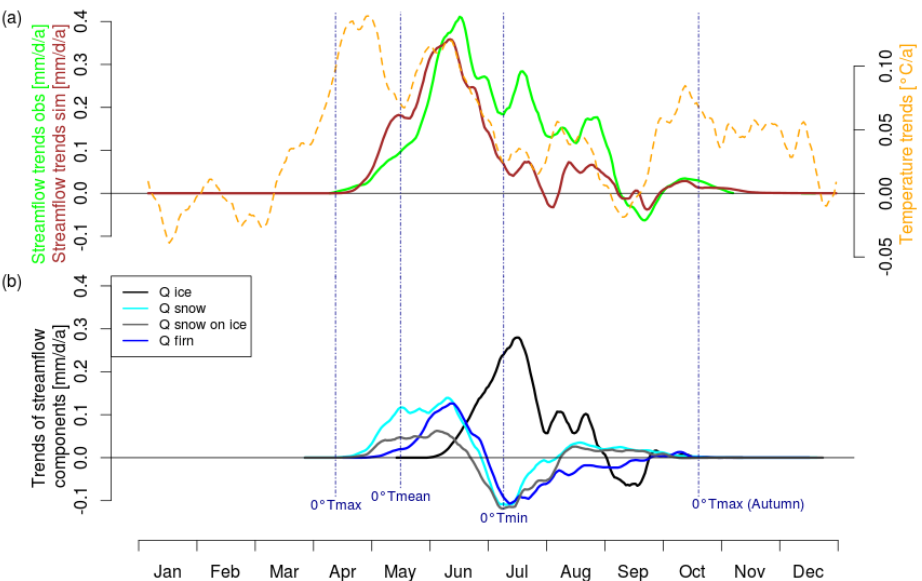
Figure 8. ( a ) Daily trends of observed and simulated streamflow along with temperature trends at the Vernagtbach catchment (1980–2007); ( b ) Daily trends of the most important simulated streamflow components (1980–2007).